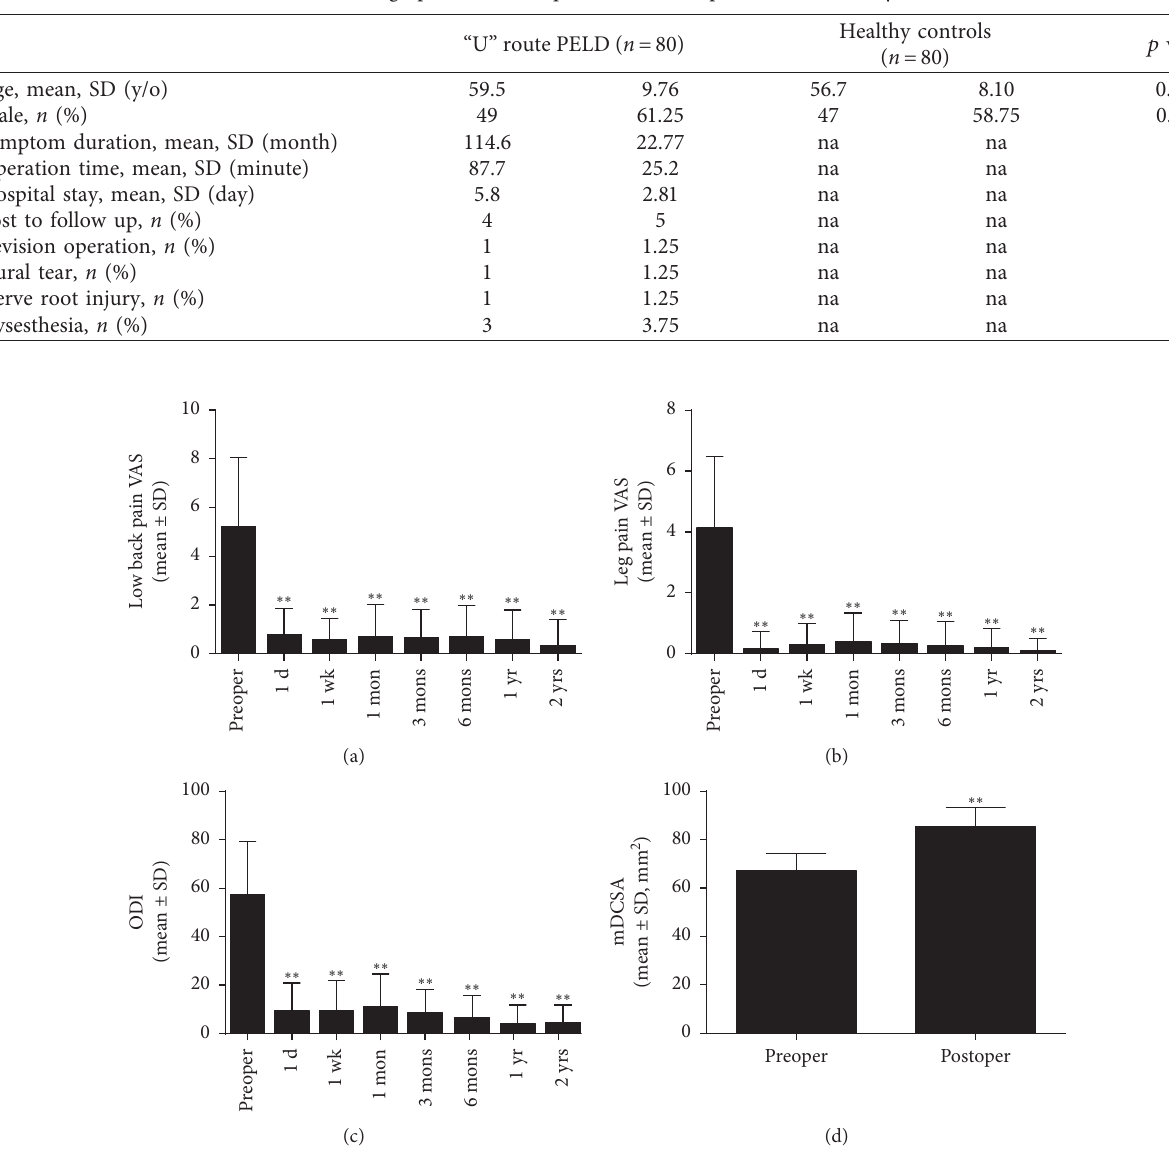
Table 1: The demographics and complications of the patients and healthy controls.